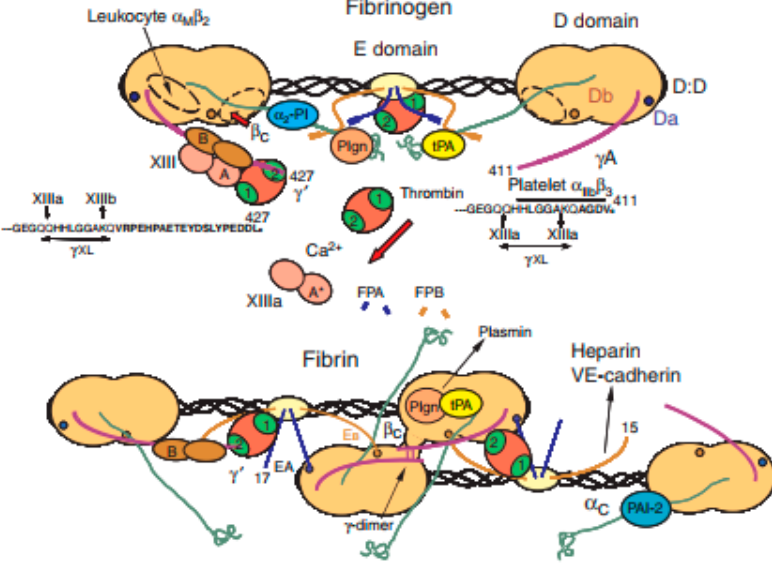
Figure 5. Schematic structures of fibrinogen and fibrin [121].